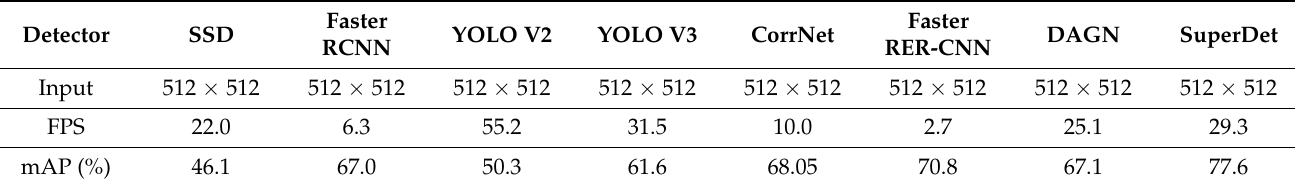
Table 3. Comparative results of different detectors on VEDAI dataset.